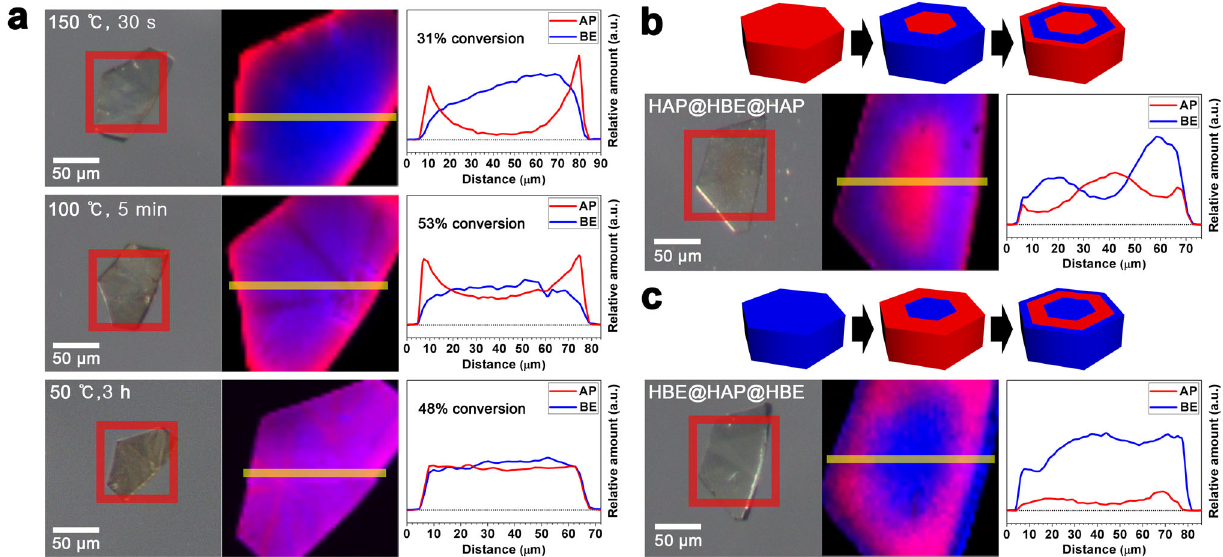
Fig. 4 Raman maps of AP and BE pillars during reverse pillar exchange from HBE to HAP and fabrication processes of multi-shell microstructures. a Optical photographs, Raman maps, and relative amounts of AP and BE pillars exhibiting a highly heterogeneous concentric inverted core – shell distribution of the pillars in the intermediate, HBE@HAP 0.31 (150,30s), a moderately heterogeneous concentric inverted core – shell distribution of the pillars in the intermediate, HBE@HAP 0.53 (100,5m), and a uniform distribution of the pillars in the intermediate, HBE – HAP 0.48 (50,3h). b Fabrication process of concentric multi-shell microstructural HAP@HBE(100,4m)@HAP 0.40 (150,30s) and its optical photograph, Raman map, and relative amounts of AP and BE pillars across the crystals. c Fabrication process of concentric inverted multi-shell microstructural HBE@HAP(150,1m)@HBE 0.87 (100,30s), and its optical photograph, Raman map, and relative amounts of AP and BE pillars across the crystals. In the schematic diagrams and Raman maps of the crystal, red and blue indicate the distribution of AP and BE pillars, respectively, while pink and purple indicate the homogeneous distribution of AP and BE pillars at different mole